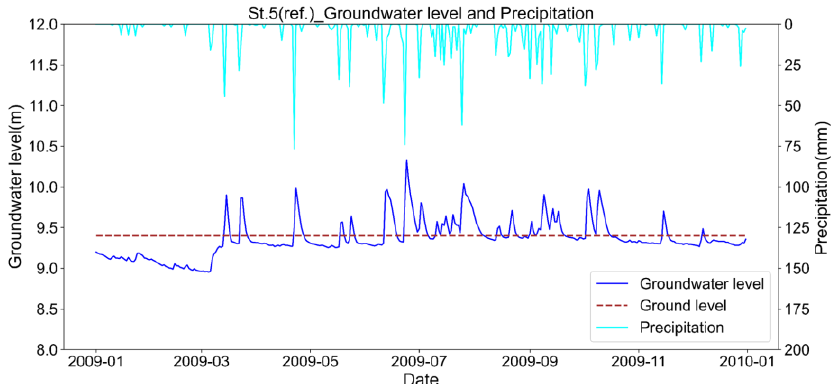
Figure 5. Time series of groundwater level and precipitation at St.5 (ref.) in 2009.